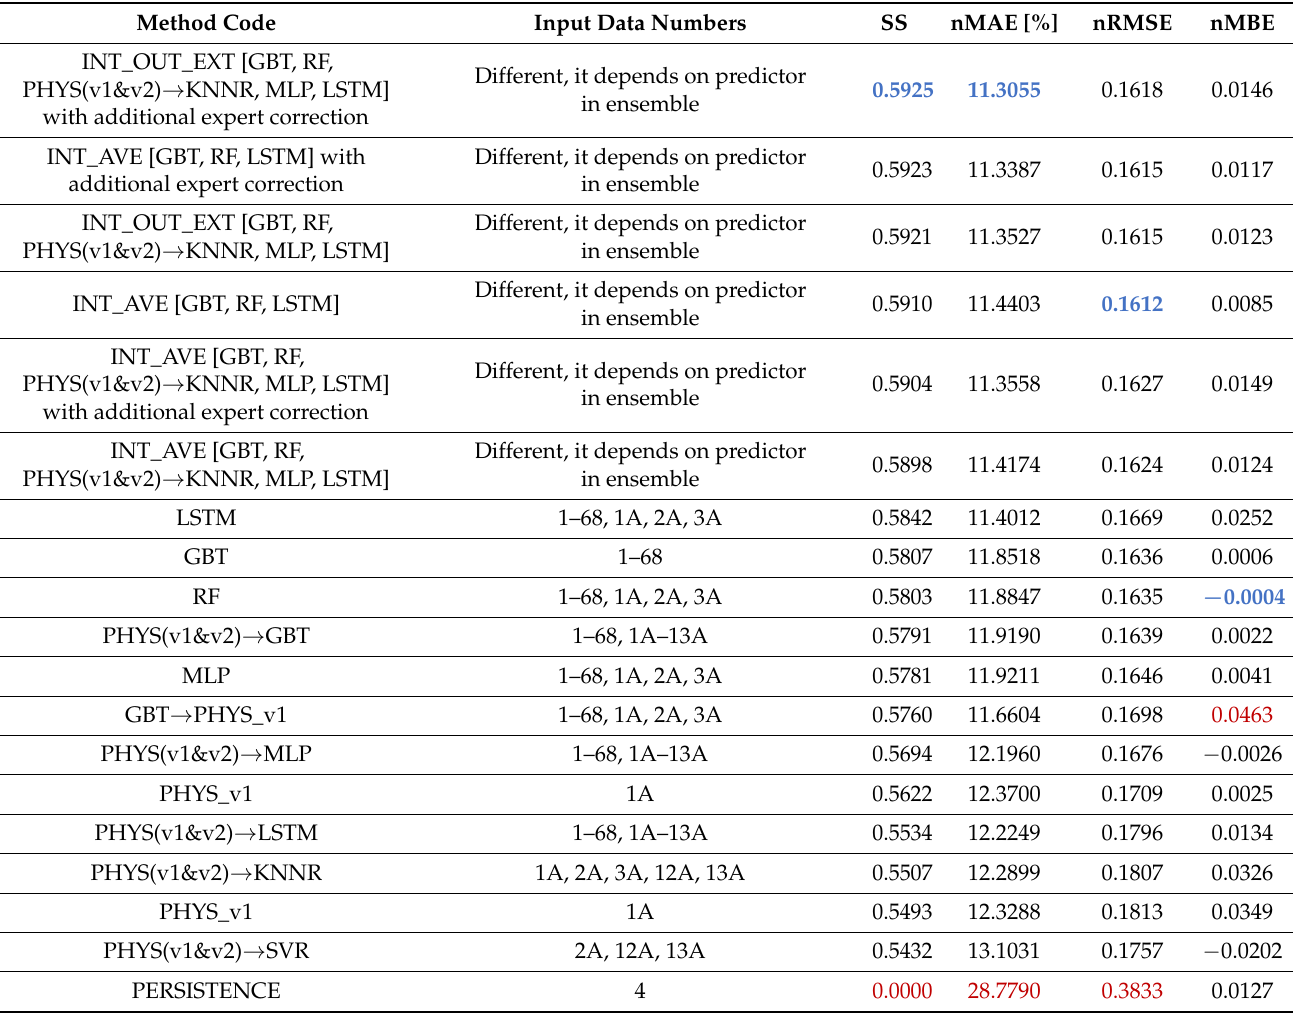
Table 9. Measures of performance of the proposed single, ensemble and hybrid methods with different sets of input data (test subset) for Wind Farm